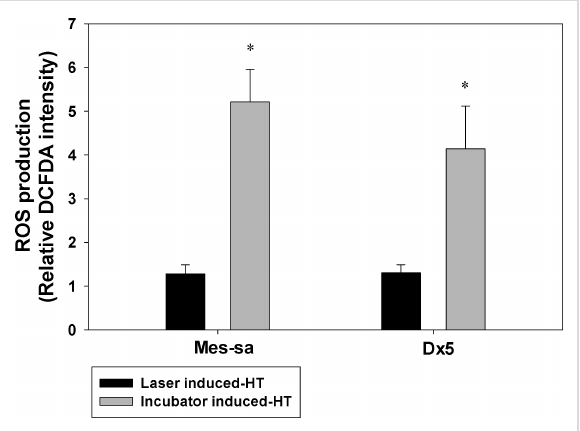
Figure 5: HT-induced VEGF expression after laser/NP and incubator was measured in MES-SA and Dx5 cells. VEGF secretion was measured by using VEGF ELISA. The obtained VEGF expression amount was normalized to SRB value as an indicator of cellular protein amount. All the values measured were then normalized to the controls. * p < 0.05 indicates significant VEGF expression was observed in incu- bator HT as compared to control. Laser/NP HT did not result in enhanced VEGF expression. Data presented as mean ± SD, n =